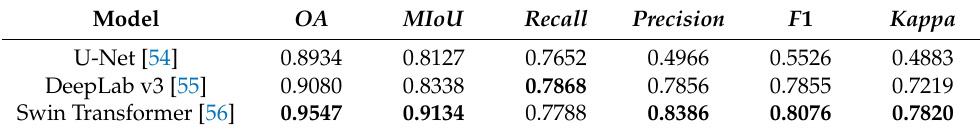
Table 2. Model accuracy evaluation.